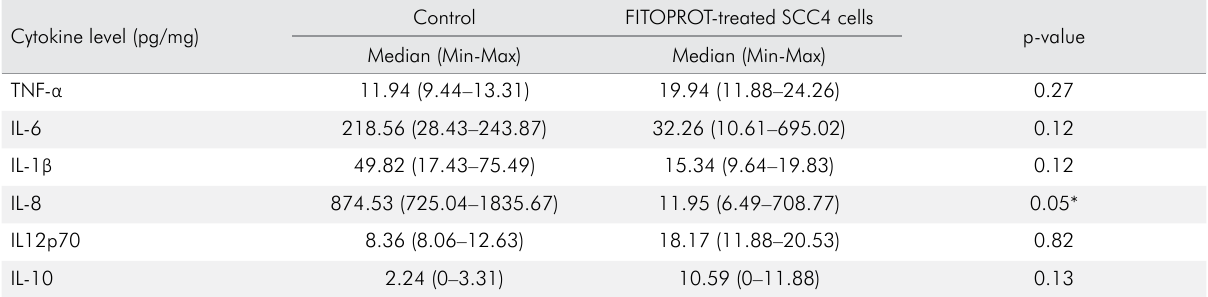
Table. Effects of FITOPROT (0.0625%) on the levels (pg/mg) of inflammatory cytokines produced by SCC4 cells. Cytokine level